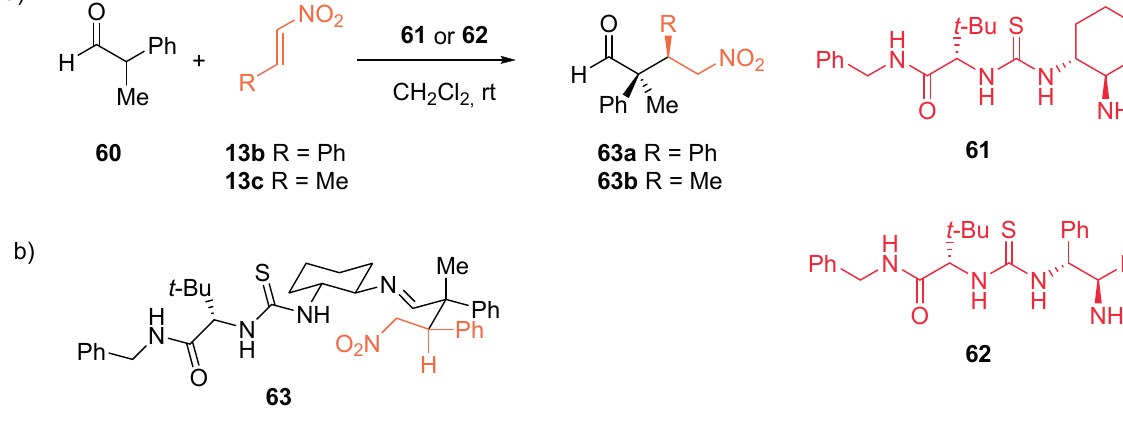
Figure 14. Enantioselective conjugate addition of α , α -disubstituted aldehydes to nitro-olefins ( a ); detected iminium intermediate ( b